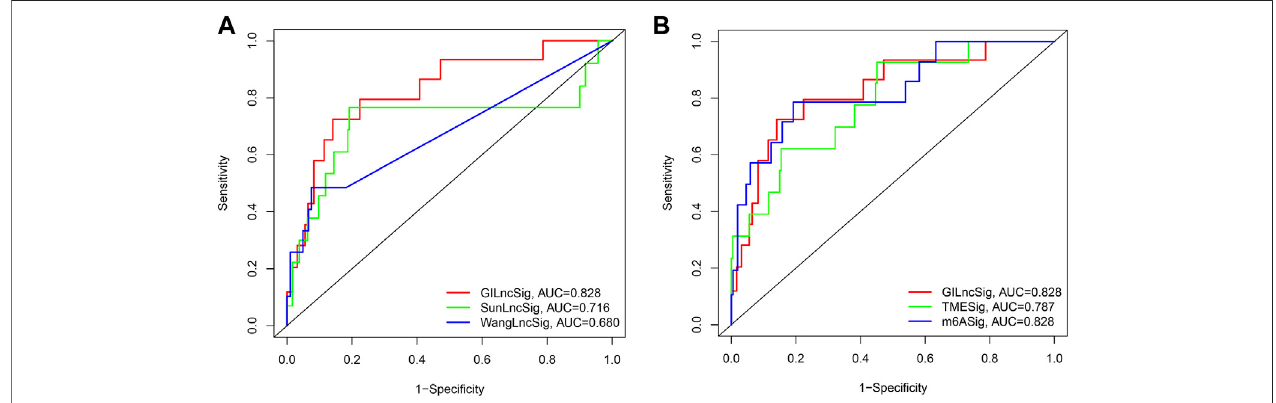
FIGURE 7 | Receiver operating characteristic analyses of the GILncSig, other lncRNA-related signatures and molecular biomarkers. (A) Receiver operating characteristic analyses of the GILncSig, WanglncSig and SunlncSig at 3 years. (B) Receiver operating characteristic analyses of the GILncSig, m6ASig and TMESig at 3